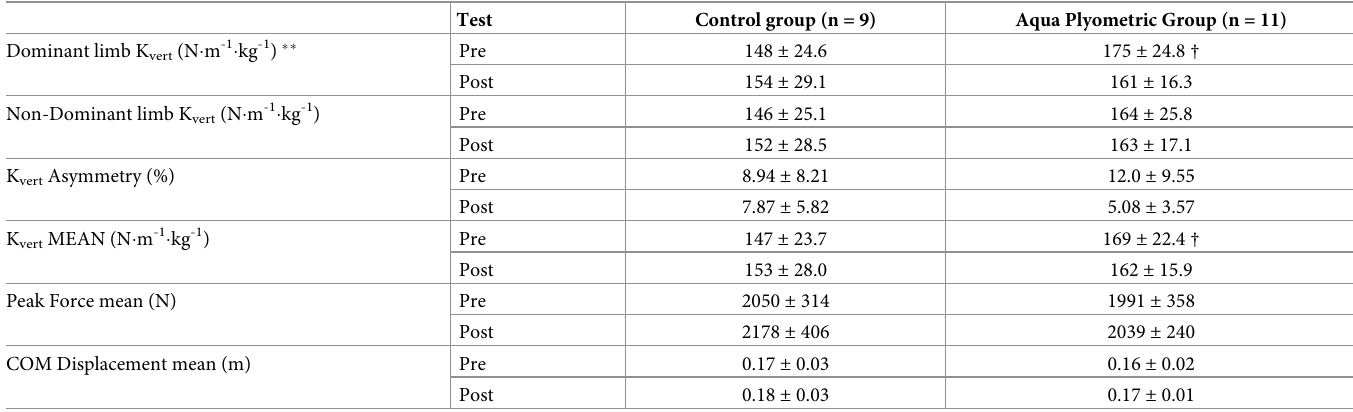
p < 0.05, partial η 2 = 0.22) and peak power (F = 5.61, p < 0.05, partial η 2 = 0.24). The peak velocity showed a quasi-significant interaction (F = 3.98, p = 0.06, partial η 2 = 0.18). The SJ showed a significant interaction for peak velocity (F = 8.41, p < 0.01, partial η 2 = 0.32), with post-hoc tests revealing a large effect size between pre- and post-training in the APG only (+15.2%, p < 0.05, d = 0.98). Additionally, a significantly large effect pre- and post-interven- tion was revealed for peak power between groups (F = 8.48, p < 0.01) with only the APG